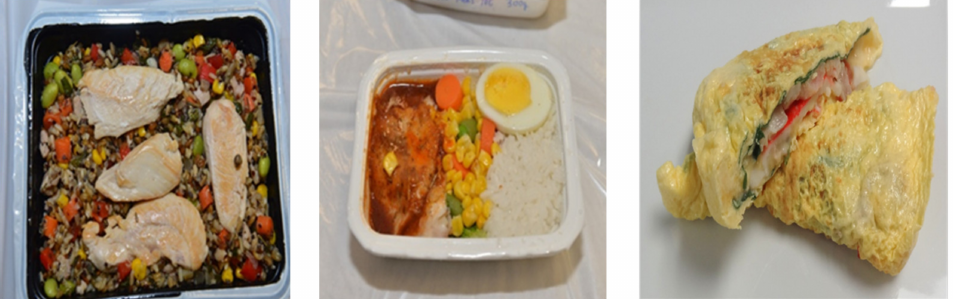
Figure 3. Thermally processed meals in 20 oz (herb chicken, pilaf, and vegetables— left ) and 10 oz (egg, vegetables and rice— center and seafood omelet— right ) trays using MAPS